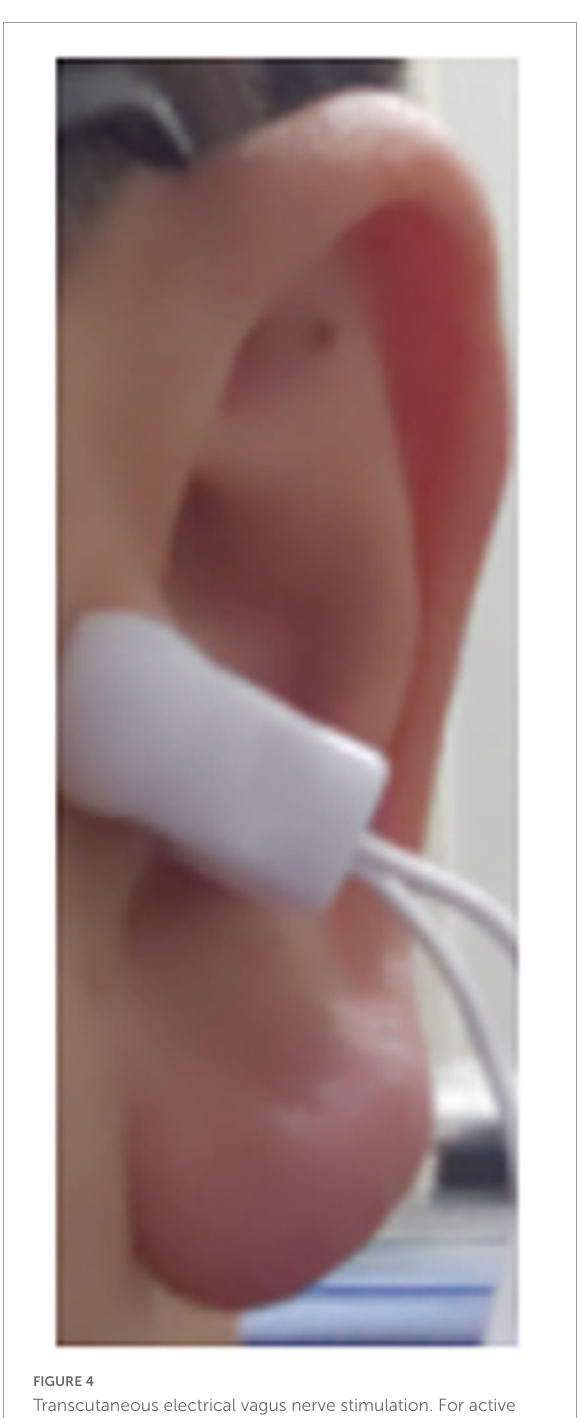
FIGURE4 Transcutaneous electrical vagus nerve stimulation. For active stimulation, the ear clip was attached to the tragus, which is innervated by the auricular branch of the vagus nerve.